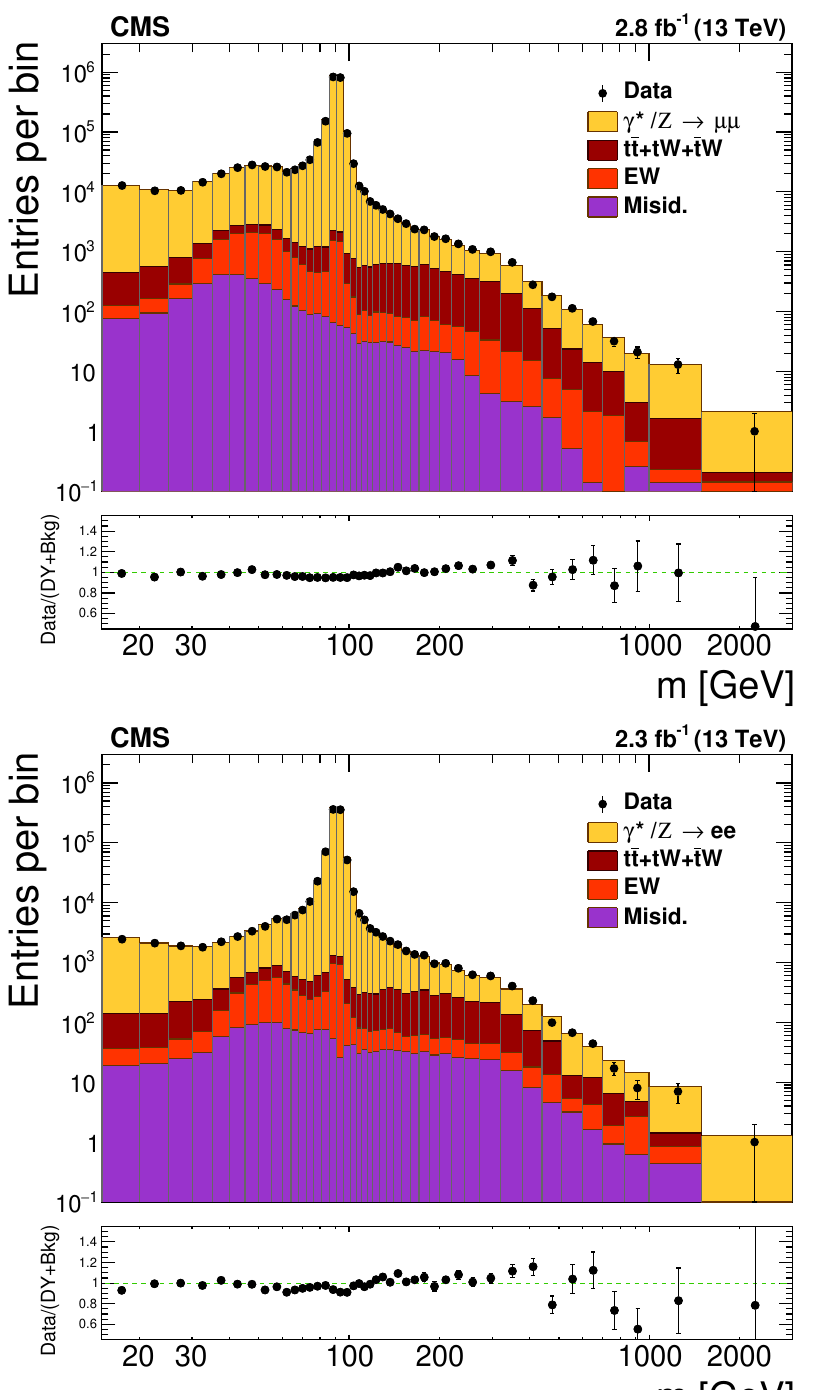
Figure 1 . The observed dimuon (top) and dielectron (bottom) invariant mass spectra within the detector acceptance. The \EW" label indicates the contributions from the DY production of (cid:28) + (cid:28) (cid:0) , WW, WZ, and ZZ processes. The \Misid." label corresponds W +jets and QCD multijet backgrounds. Each MC process is normalised using the most accurate theoretical cross section value available. The error bars on the data points represent the statistical uncertainty only.